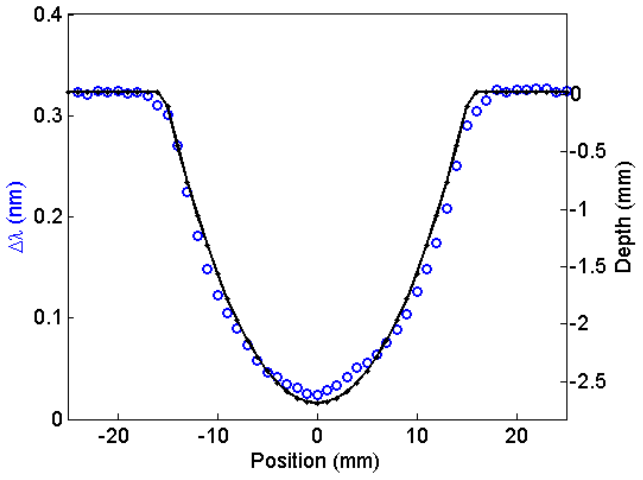
Figure 11. Change in wavelength detected by sensor A (circles) obtained when a fabricated semi-spherical pit with 30-mm outside diameter and 2.7-mm depth is scanned under sensor A at a 1.2-mm standoff distance. The depth profile measured by a depth gauge is also shown (solid line).